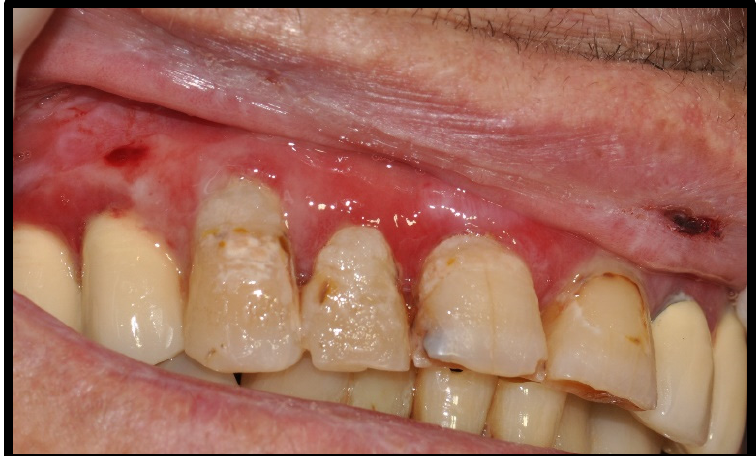
Figure 3. Exacerbation of oral lichen planus; the biopsy was documented years before the cancer diagnosis. The patient, on pembrolizumab and switched to ipilimumab, presented with oral/gingival pain, bleeding, and the inability to perform oral hygiene.